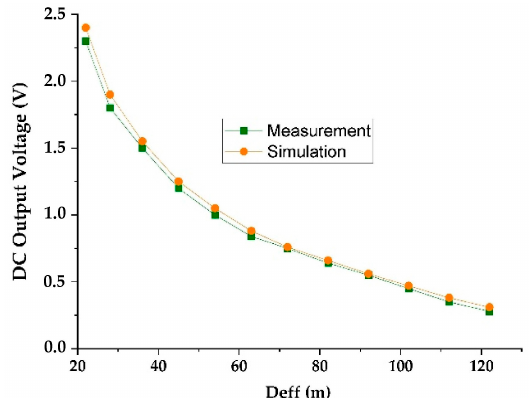
Figure 15. Simulated and measured DC output voltage for 2 k Ω resistance load.